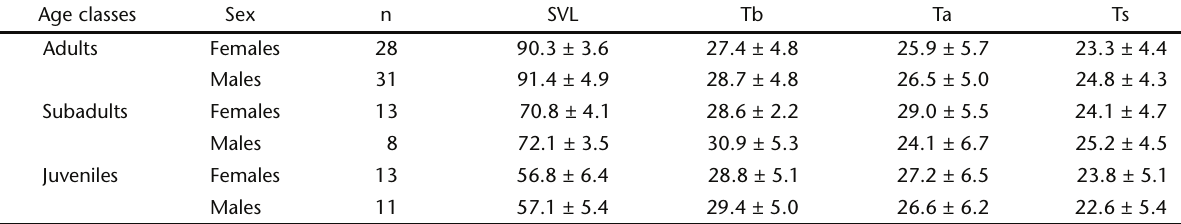
Table I. Descriptive statistics (mean ± standard deviation) of body size – snout-vent length (SVL, mm), body temperature (Tb), air temperature (Ta) and substrate temperature (Ts) of females and males of different age classes for P. palluma. (n) Sample